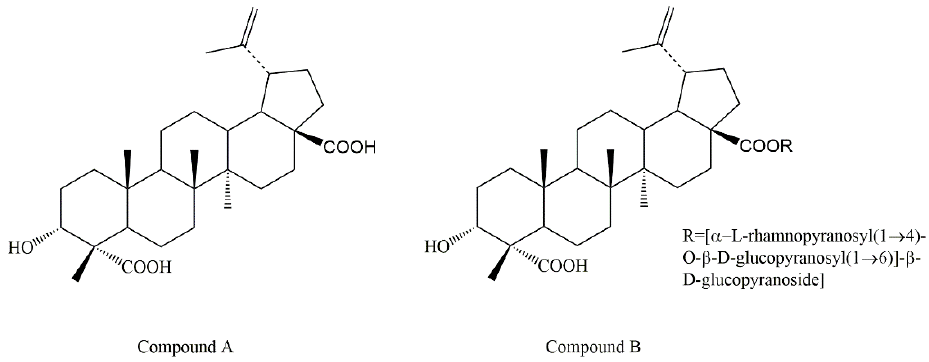
Figure 1. Chemical structures of compounds A and B .